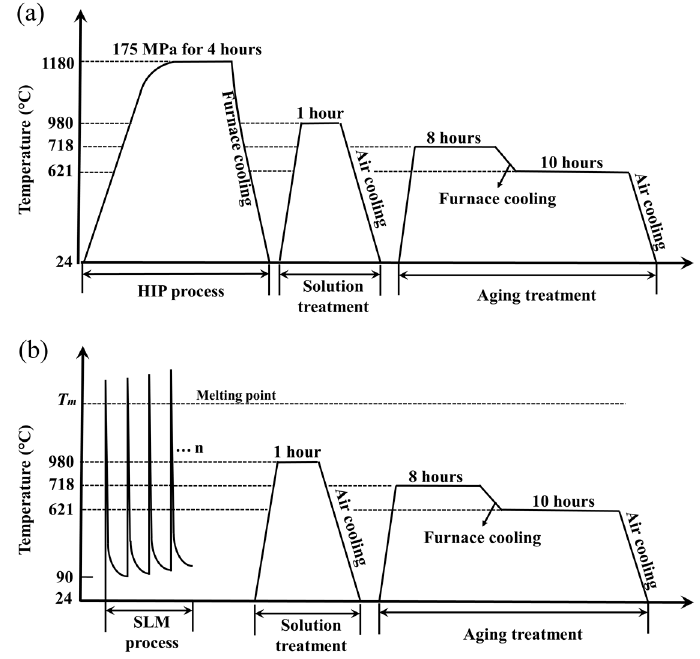
Figure 3. Heat history of the ( a ) HIP process and ( b ) SLM process.